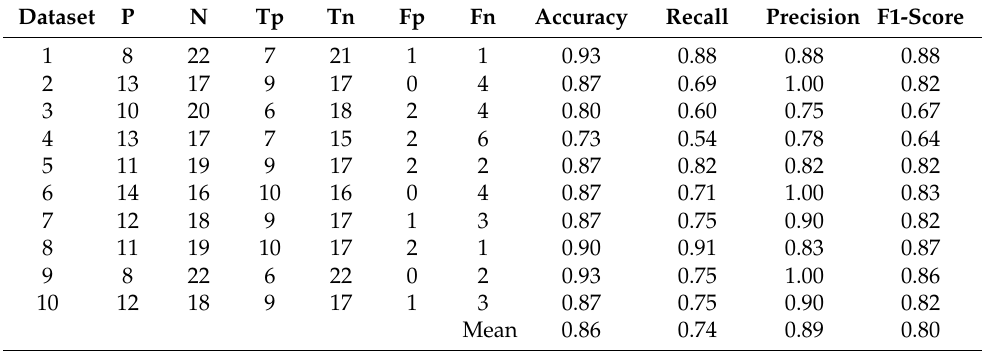
Table 5. G.B. models trained and tested on ten randomly selected